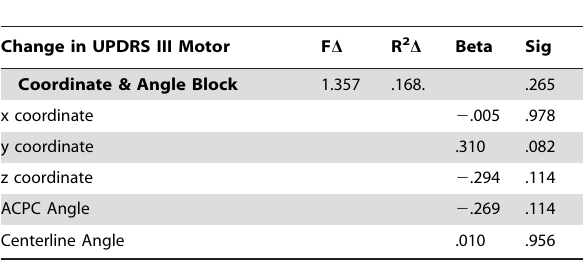
Table 7. Block Analysis of STN Patients. Table 8. Block Analysis of GPi